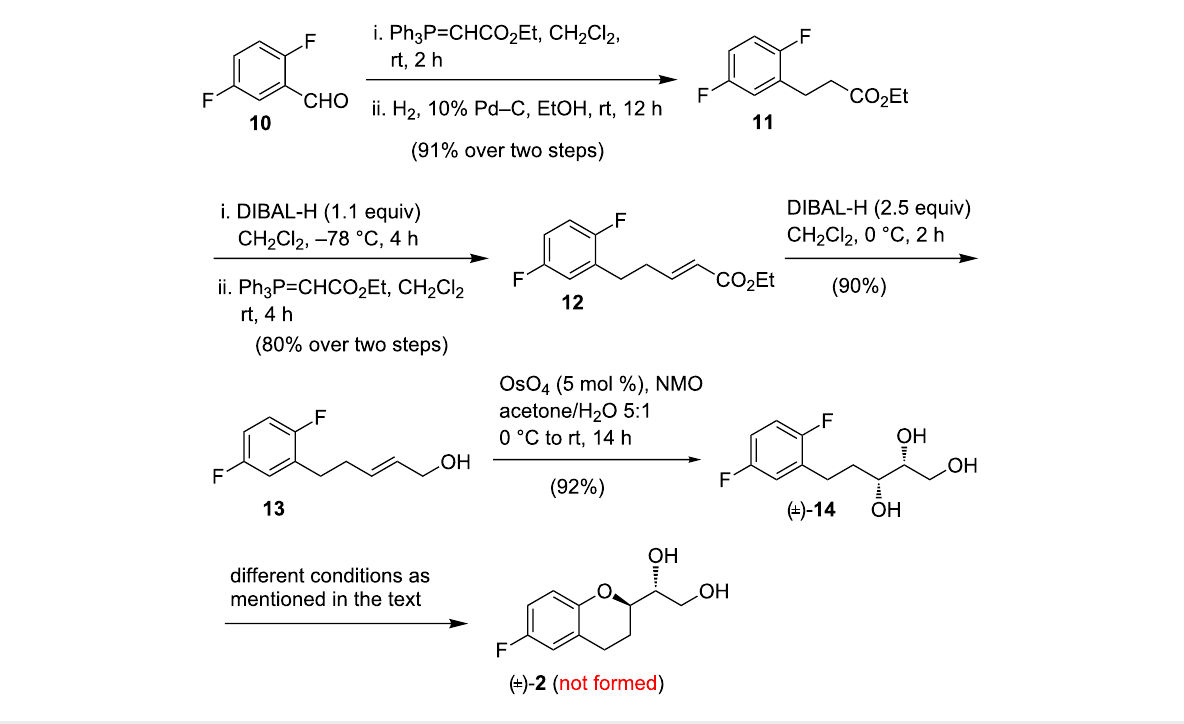
Scheme 2: Attempted synthesis of (±)- 2 via intramolecular S N Ar